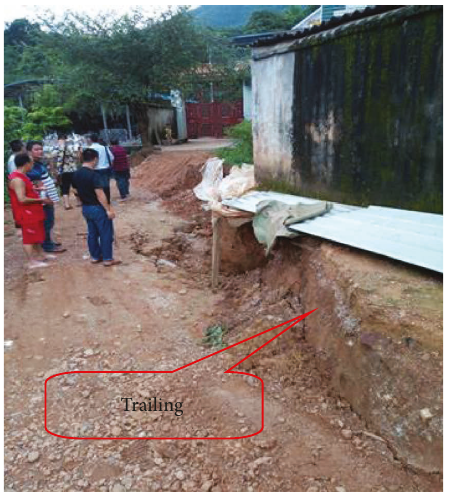
Figure 16: Trailing edge boundary of the landslide.